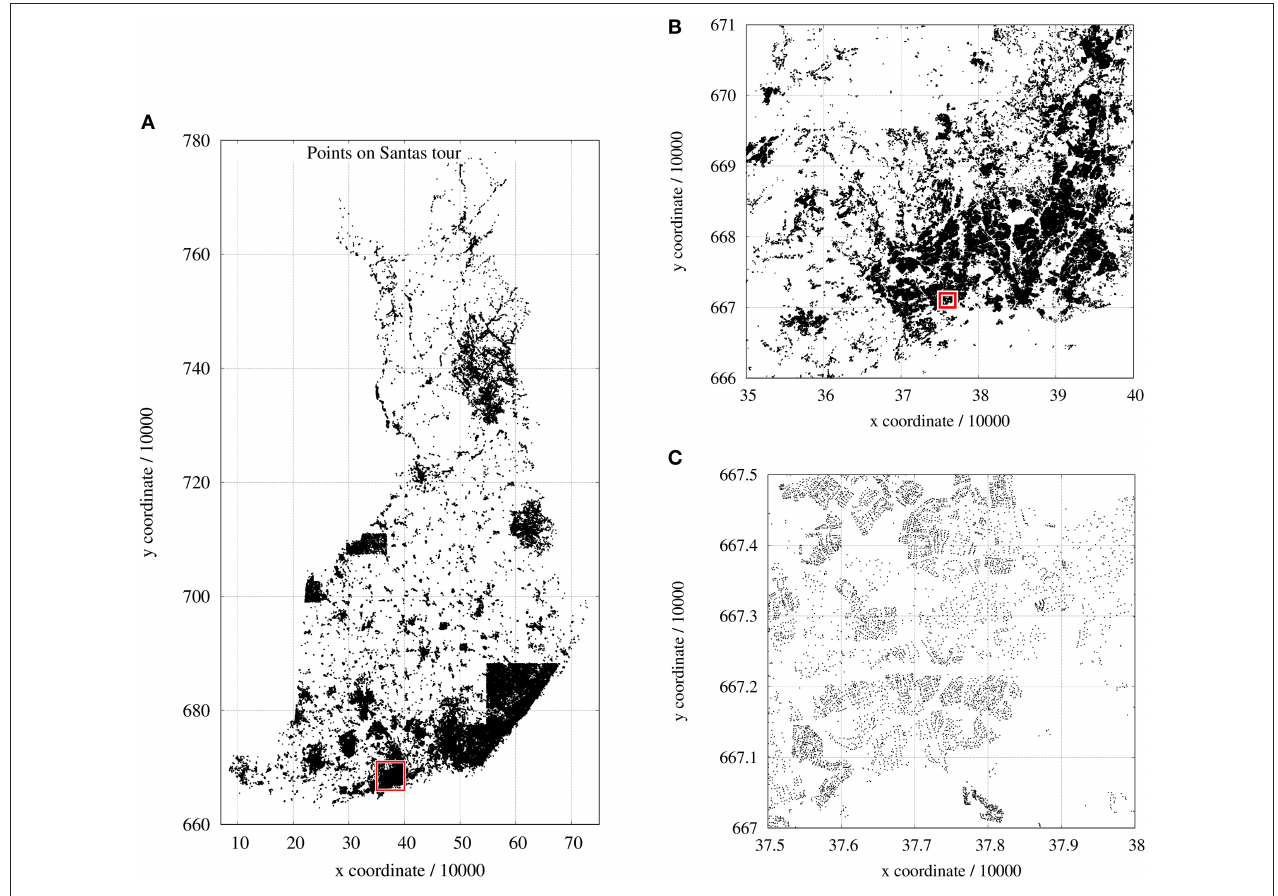
FIGURE 1 | A special instance of TSP: the Traveling Santa Problem: (A) entire map of all 1.437.195 points; (B) close-up of (A) ; (C) close-up of (B) .